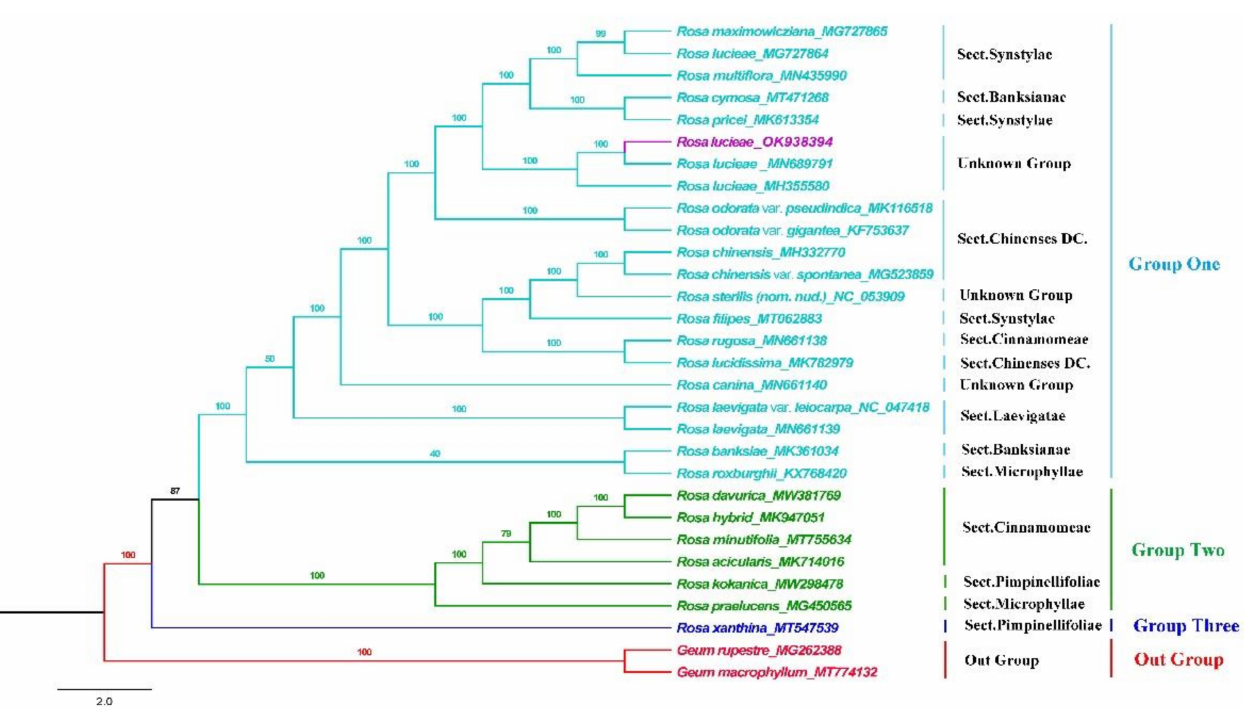
Figure A1. Molecular phylogenetic tree of Rosa based on 30 chloroplast genome sequences by maximum likelihood